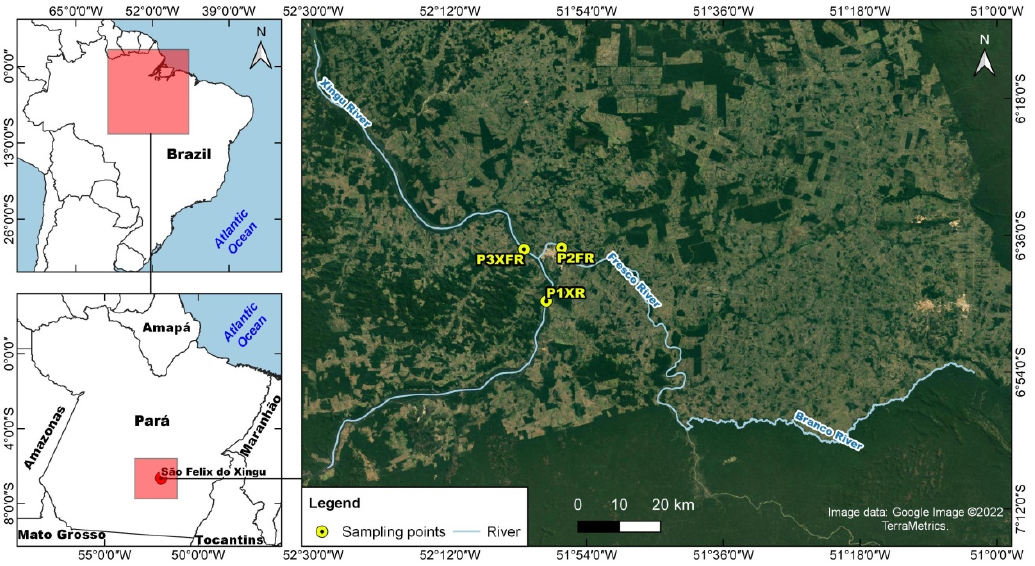
Figure 1. Study area and locations of the three sites for collection of water and aquatic invertebrates. Three rivers are shown: the Xingu River and the Fresco River, in the municipality of São Félix do Xingu, Pará state, and the Branco River, in the municipality of Ourilândia do Norte, Pará state, Brazil. Source image data: Google Image ©2022 TerraMetrics.